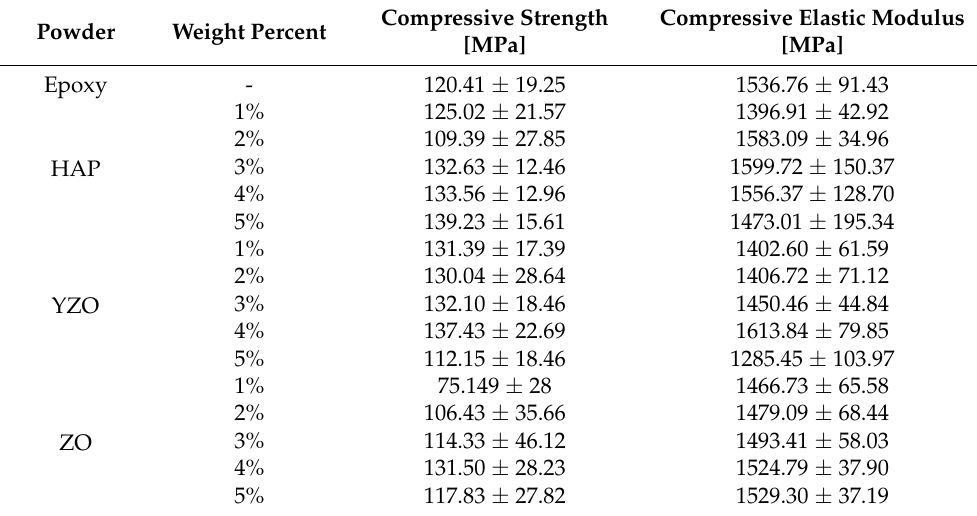
Table 2. Results of the compression test according to the type of bioceramic–epoxy composite